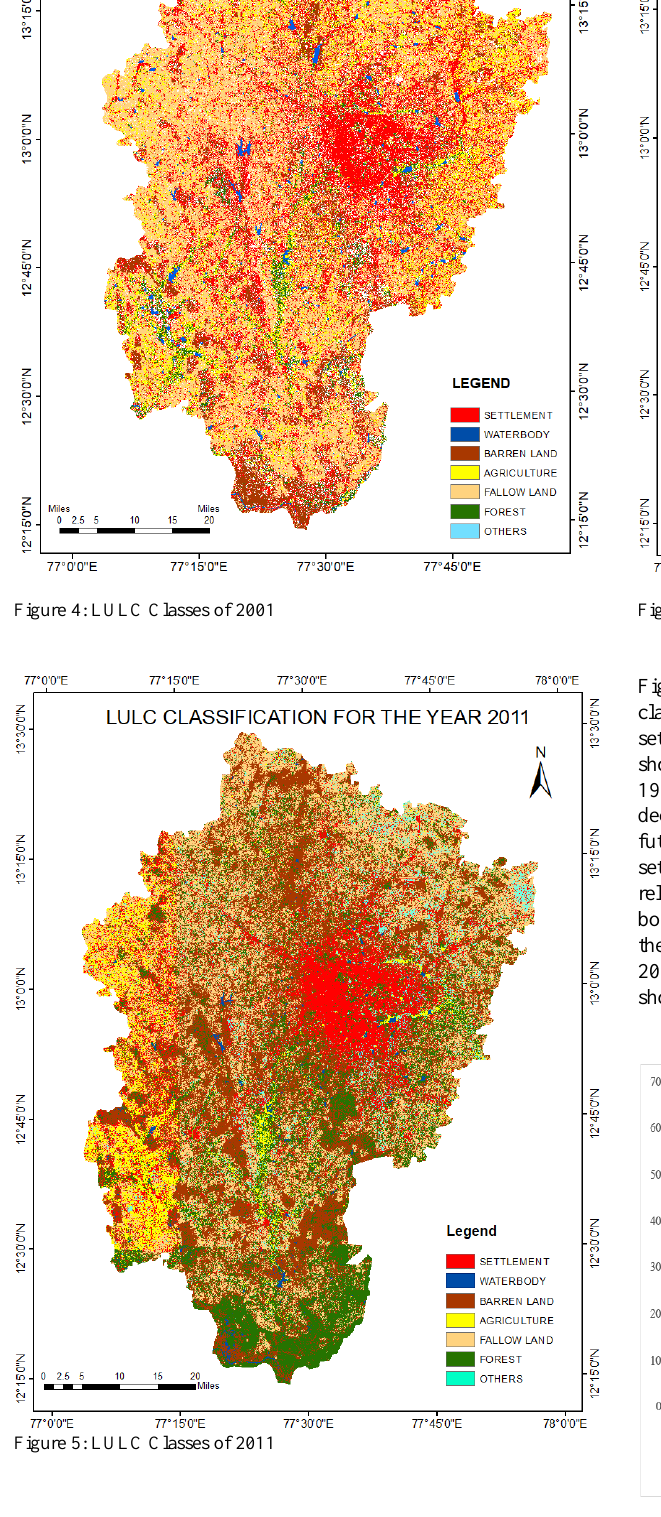
Figure 7: Area Under Different LULC Classes in